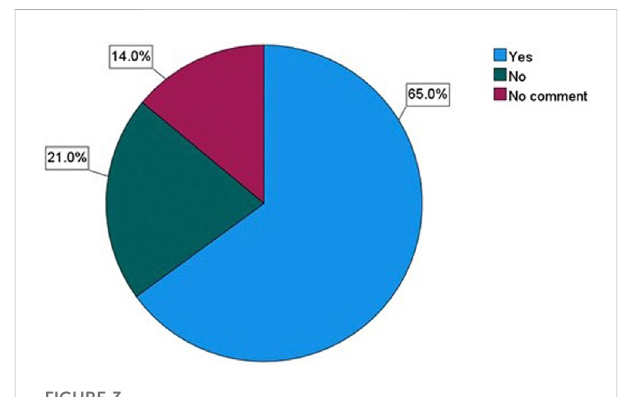
FIGURE 3 The public opinion about whether MSW charging should be